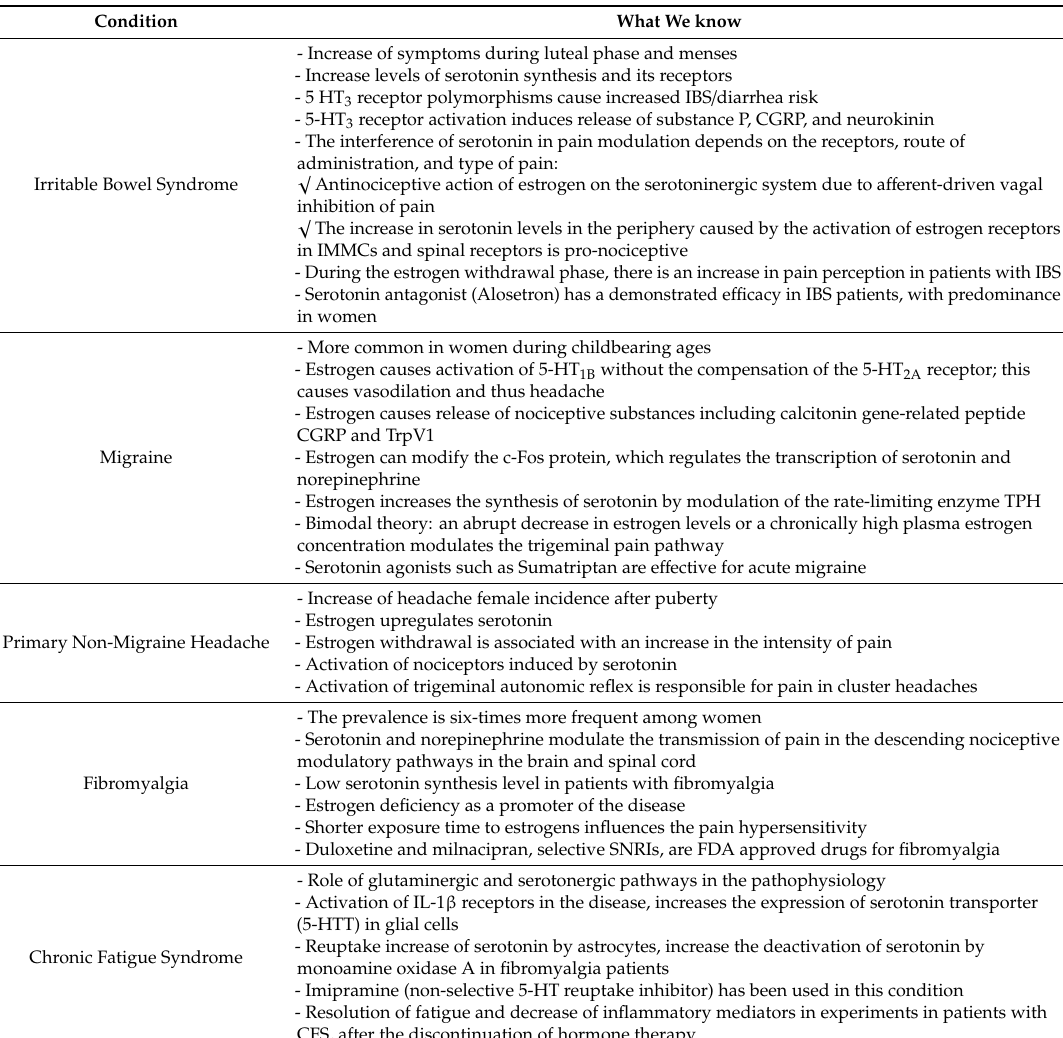
Table 1. Serotonin and estrogen modulation of pain